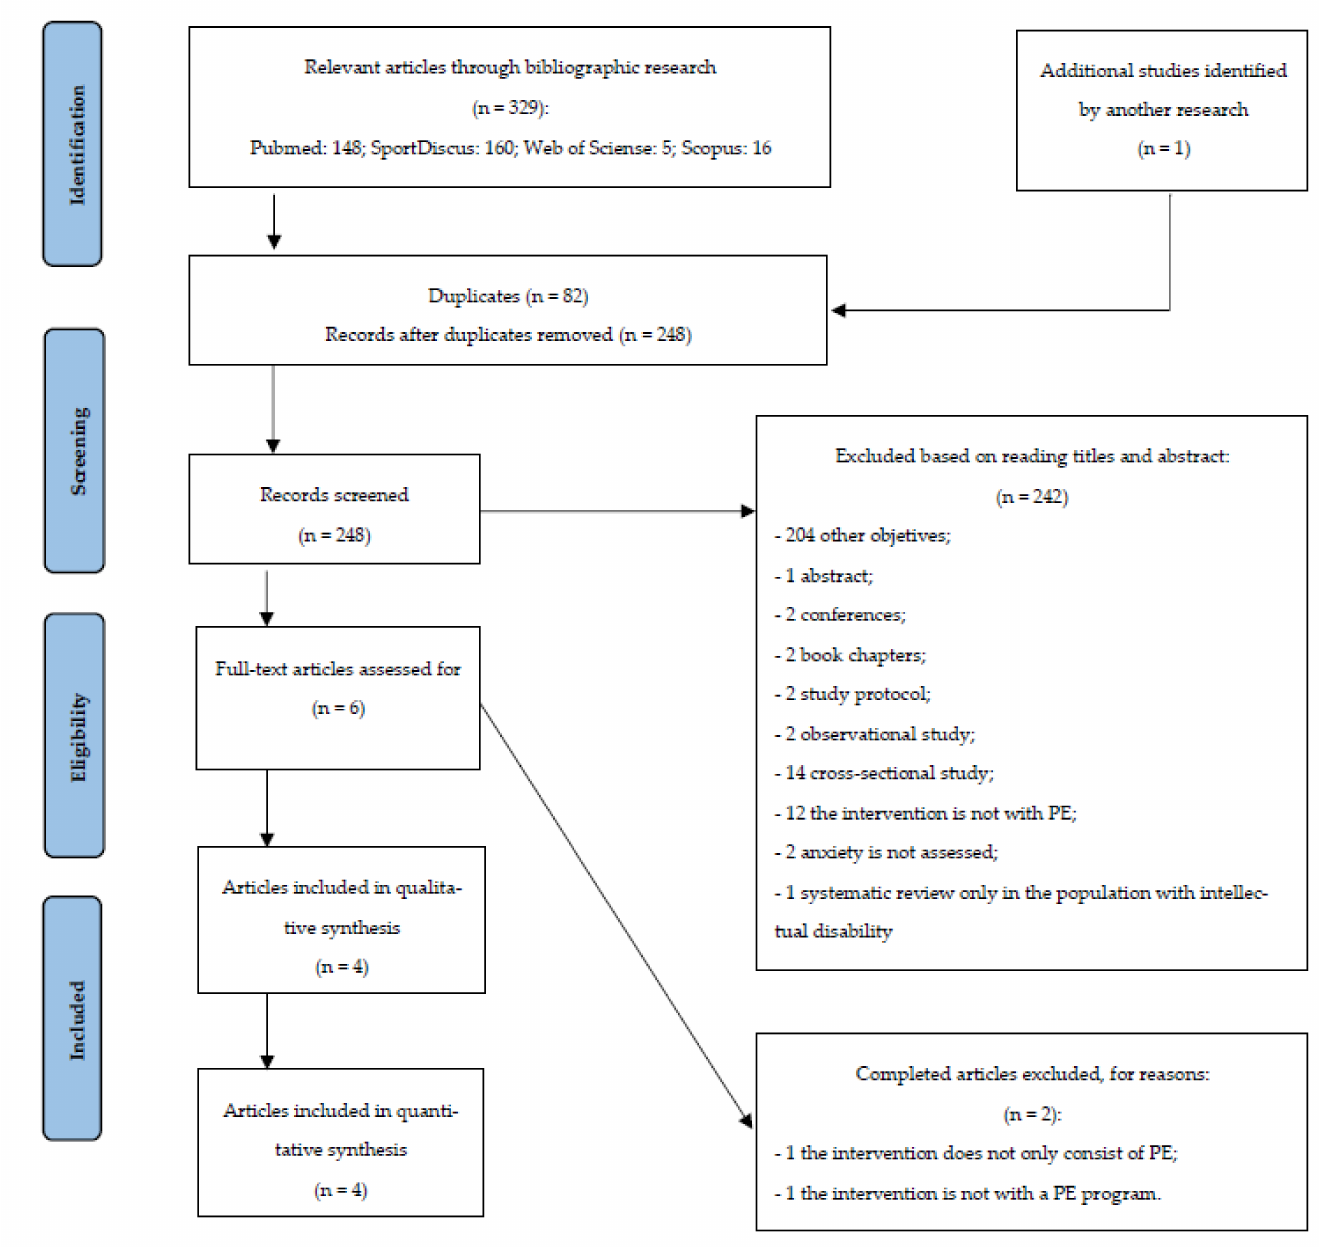
Figure 1. PRISMA flow